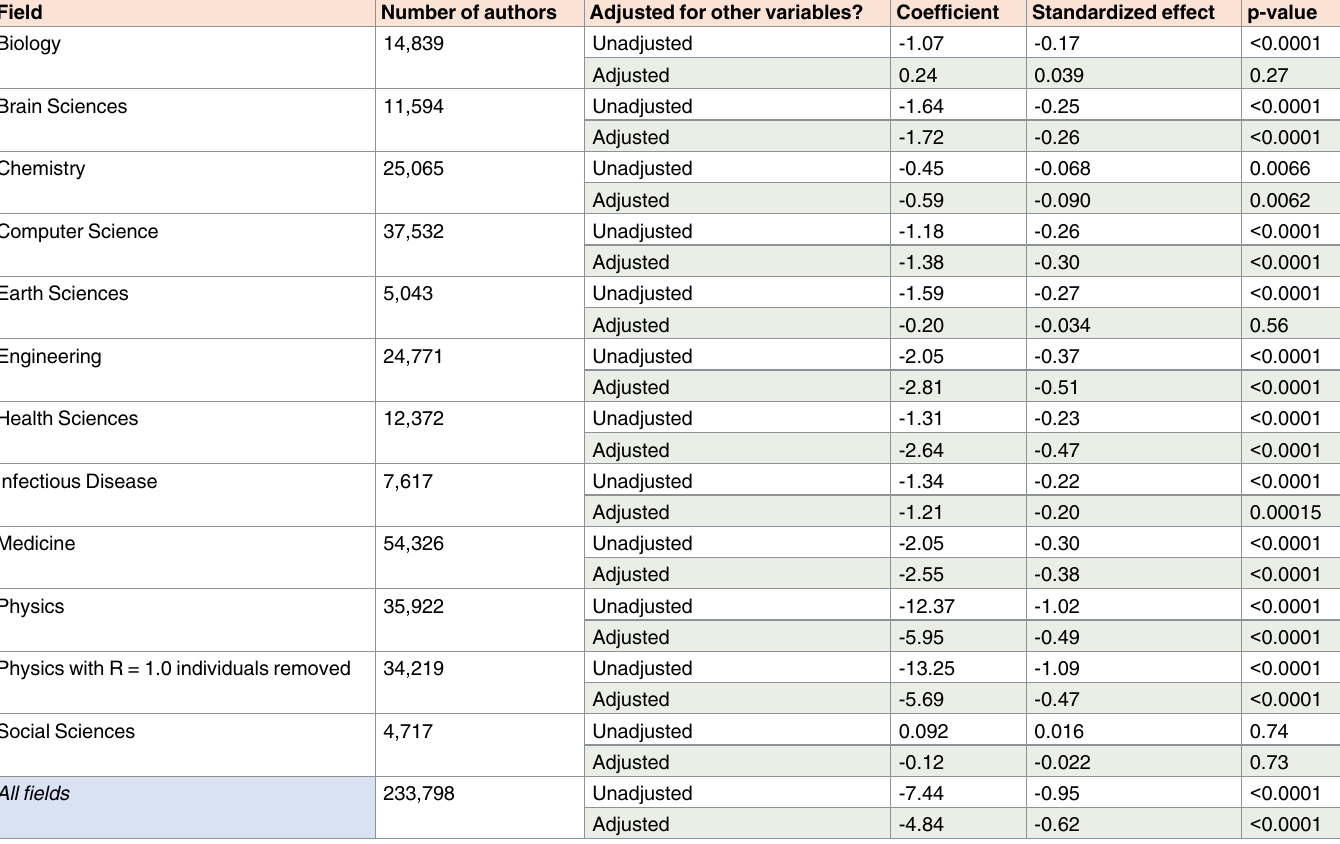
Table 2. Linear regression effectof R on h-index in 2015, separated by field. Restrictedto the 233,798authorswith N p (cid:21) 30 and I 1 (cid:21) 4 in 2015.The stan- dardizedeffect is obtained by dividingthe coefficient by the standarddeviationof h in 2015 for each field. Results are shown unadjusted,and adjusted for total publications, averagenumberof co-authors, first year of publication,US-basedor not, and gender(male or